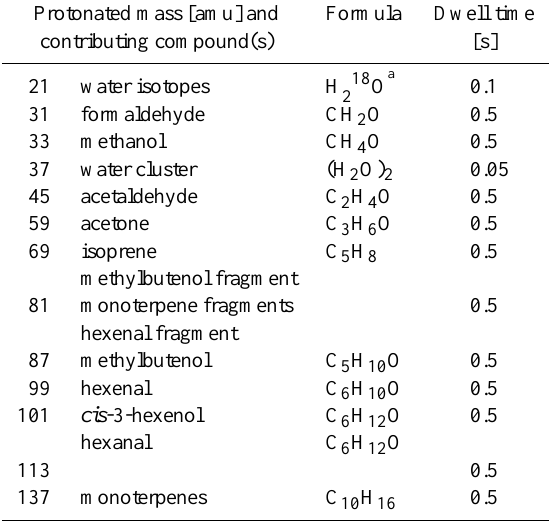
Table 1. PTR-MS measurement cycle in the DEC measurements, the compounds contributing to the measured masses, and the PTR- MS integration times. The cycle length was 6.6s.